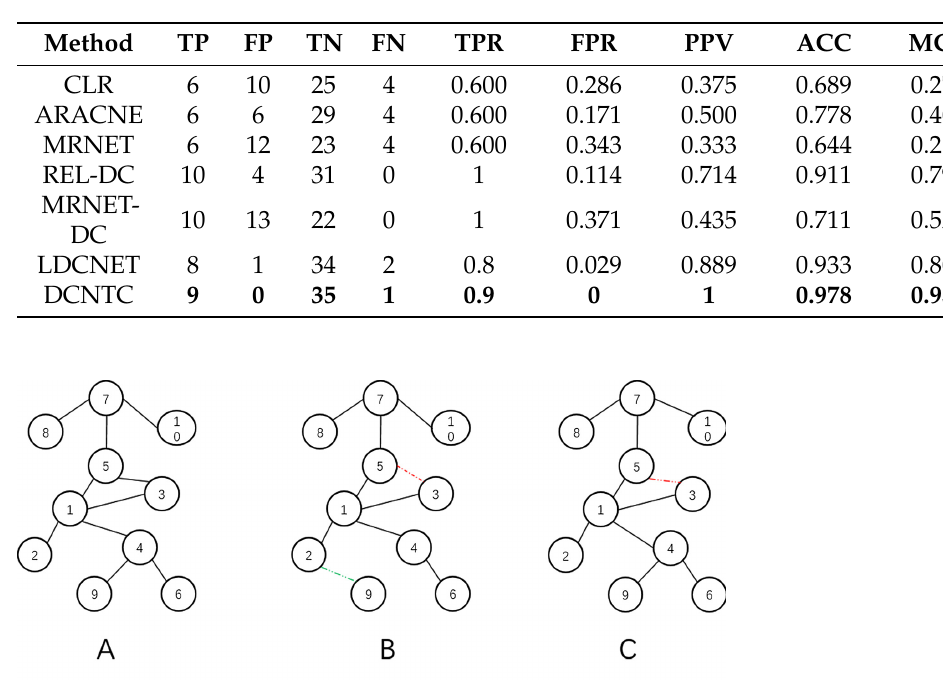
Table 1. Comparison of the performance of different methods for inferring a 10-gene network in DREAM3.